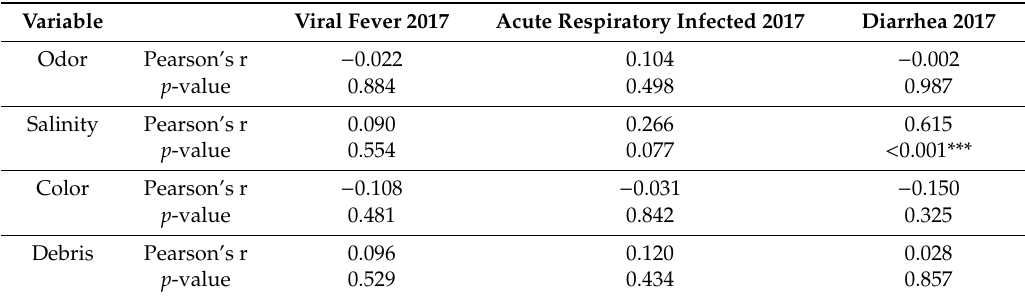
Table 1. Correlations between perceived groundwater quality and communicable diseases.